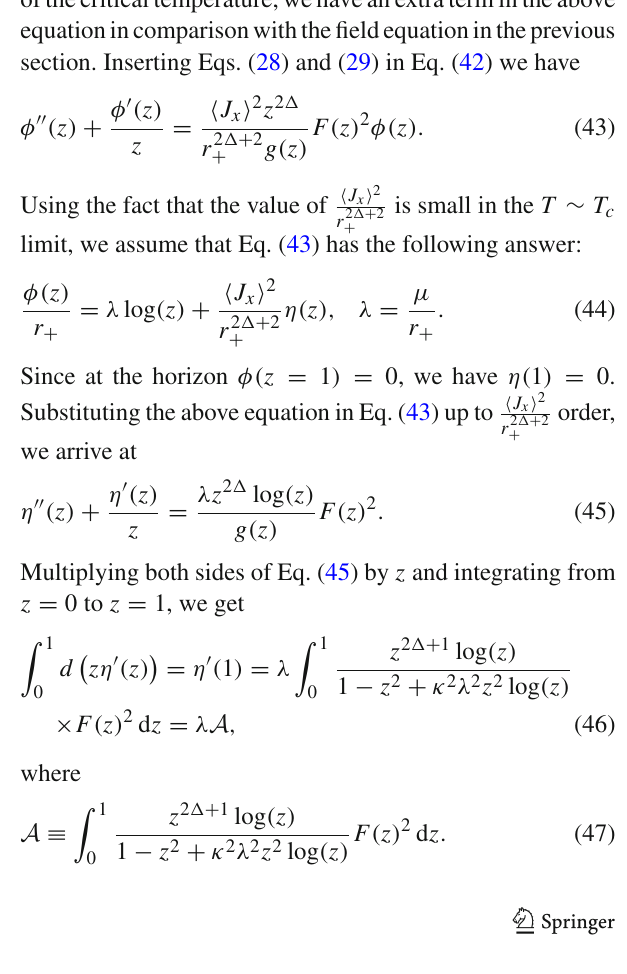
the numerical and analytical results, data are given in Table